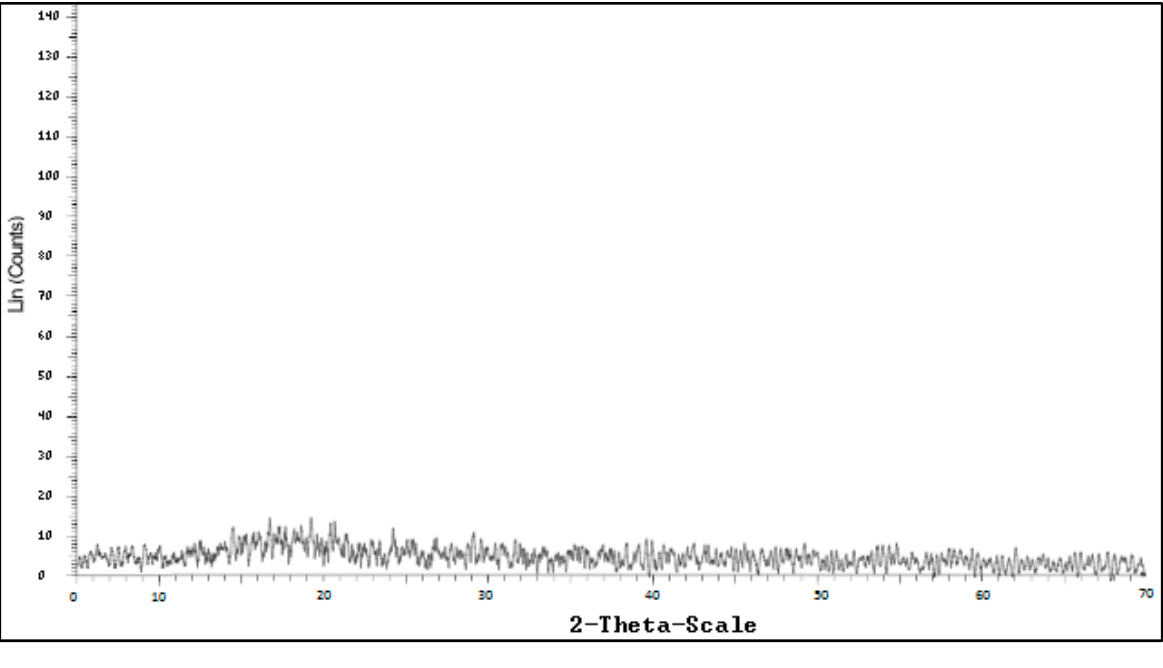
Figure 6. GPC spectroscopy of antioxidant carrageenan.